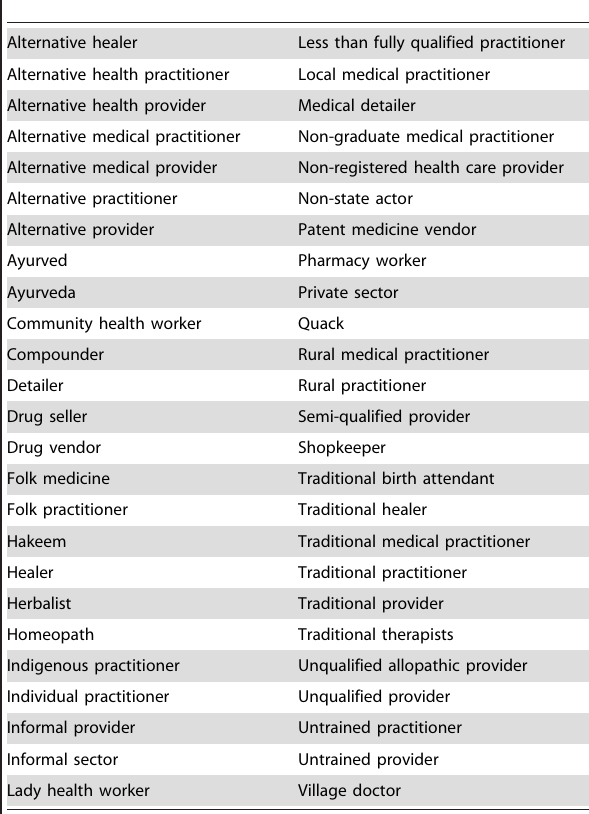
Table 1. Search Terms for Informal